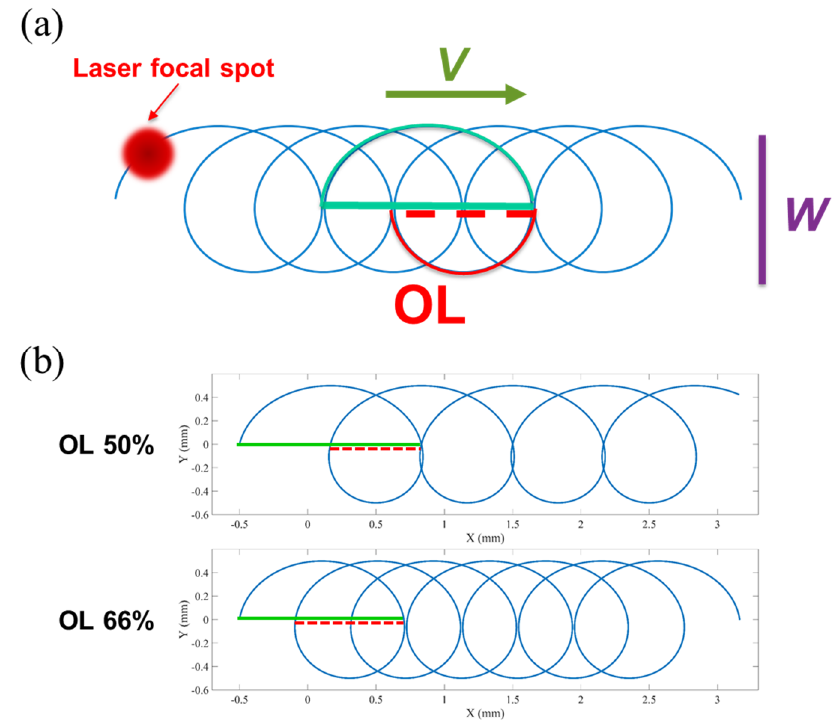
Figure 1. ( a ) A schematic diagram of the WBS and ( b ) examples of the trajectory of different OLs, 50% and 66%.